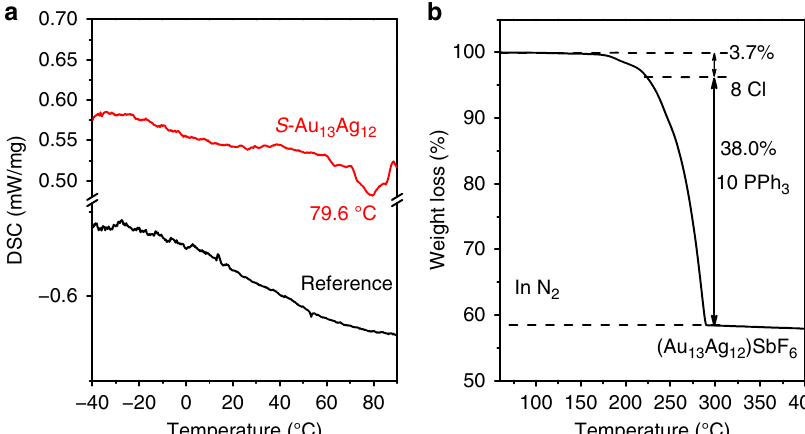
Fig. 6 Thermal analysis of the Au 13 Ag 12 nanoclusters. a DSC analysis for the conversion of the S -Au 13 Ag 12 to E -Au 13 Ag 12 under a N 2 atmosphere. b TGA test of the Au 13 Ag 12 nanoclusters under a N 2